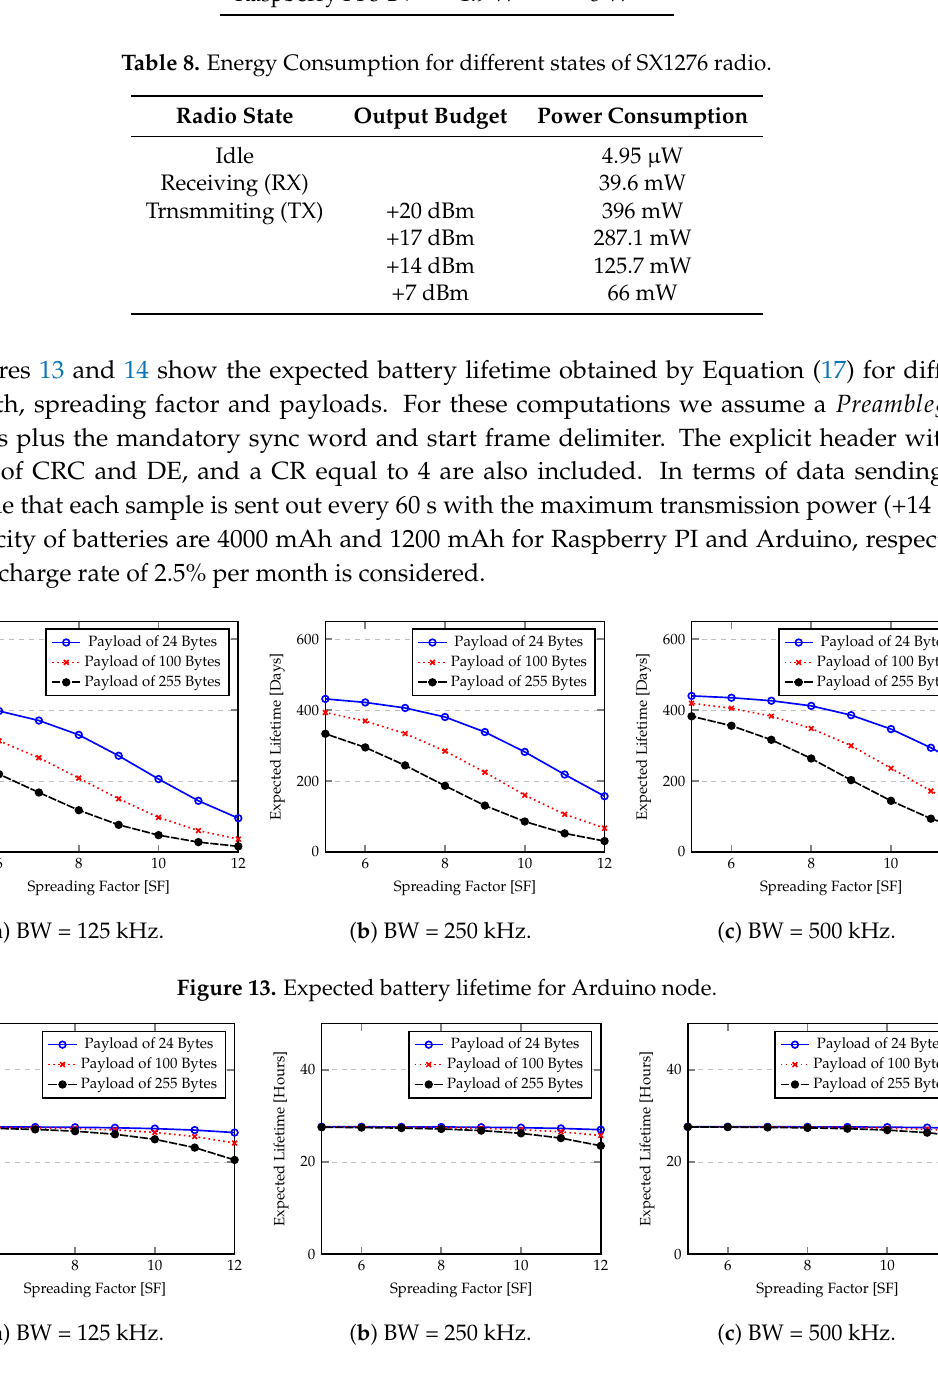
Figure 14. Expected battery lifetime for Raspberry PI 3 B+